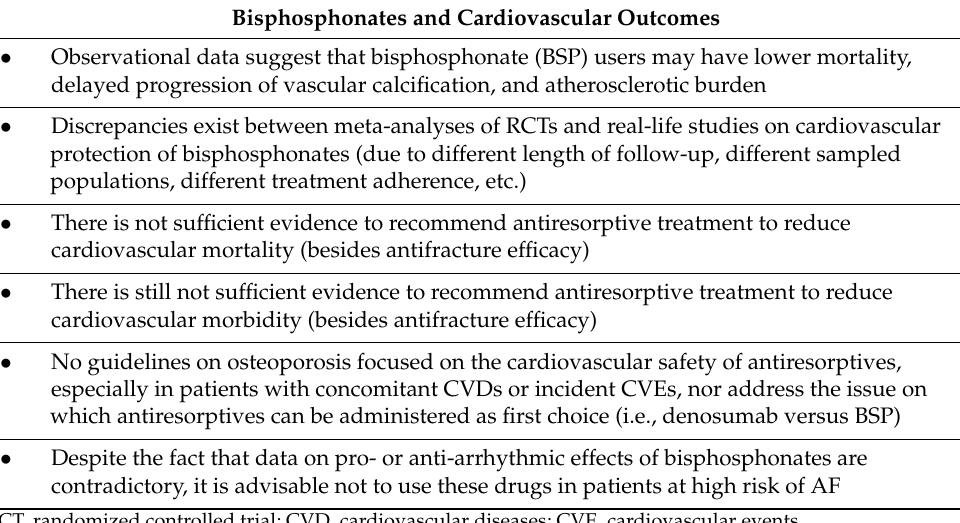
Table 2. Relationship between cardiovascular outcomes and the use of bisphosphonates in clini- cal